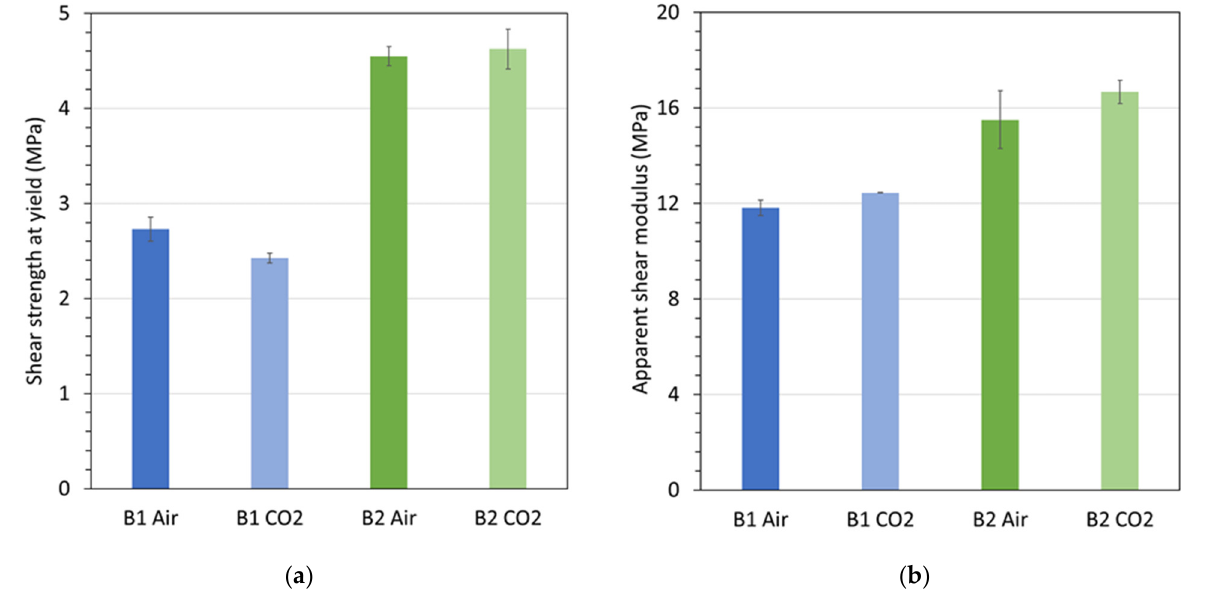
Figure 7. ( a ) Shear strength at yield and ( b ) apparent modulus for Polymers B1 and B2, each conditioned and tested at 82 °C in air and in CO 2 at atmospheric and 6.89 MPa (1000 psi) pressure.